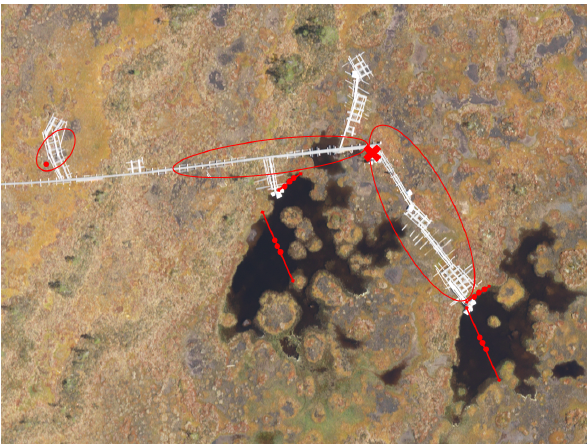
Figure 2. Aerial photo of the study site in Siikaneva bog. Red lines with dots mark the floating gas traps in open water (OW) and at the water’s edge (EW). Red circles mark the area where the gas traps were placed on bare peat surfaces (BP), which are seen as brownish- grey in the photo. The eddy covariance (EC) raft is marked with the red ×